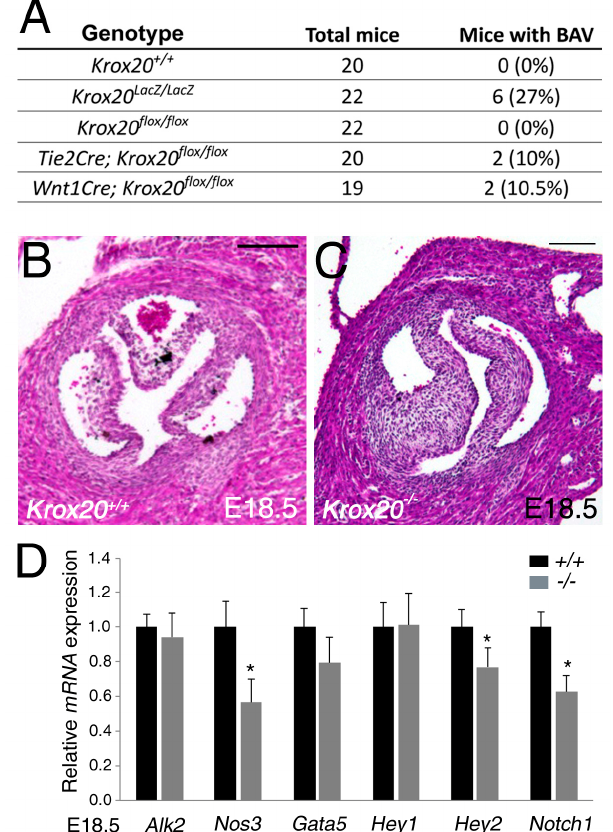
Figure 1. Modulation of gene expression in Krox20 − / − embryos. ( A ) Table depicting penetrance of bicuspid aortic valve (BAV) in Krox20 − / − , Tie2-cre;Krox20f / f , and Wnt1-cre;Krox20f / f mice. ( B , C ) Cross-sectional H&E images through the aortic valve of Krox20 +/+ ( B ) and Krox20 − / − ( C ) littermate embryos. At E18.5, left and right-coronary leaflets are observed in BAV of Krox20 − / − ( C ) embryos. ( D ) Real-time qPCR analyses were performed from isolated aortic valve of Krox20 +/+ ( n = 5) and Krox20 − / − ( n = 5) embryos at E18.5. qPCR showing normal levels of Alk2 , Gata5 , and Hey1 , and altered expression of Nos3 , Notch1 , and Hey2 in the aortic valve of Krox20 − / − embryos at E18.5. qRT-PCR experiments were performed in triplicate and expressed as mean ± SEM (* p < 0.05 using Mann–Whitney test). Scale bars: 100 μ m.